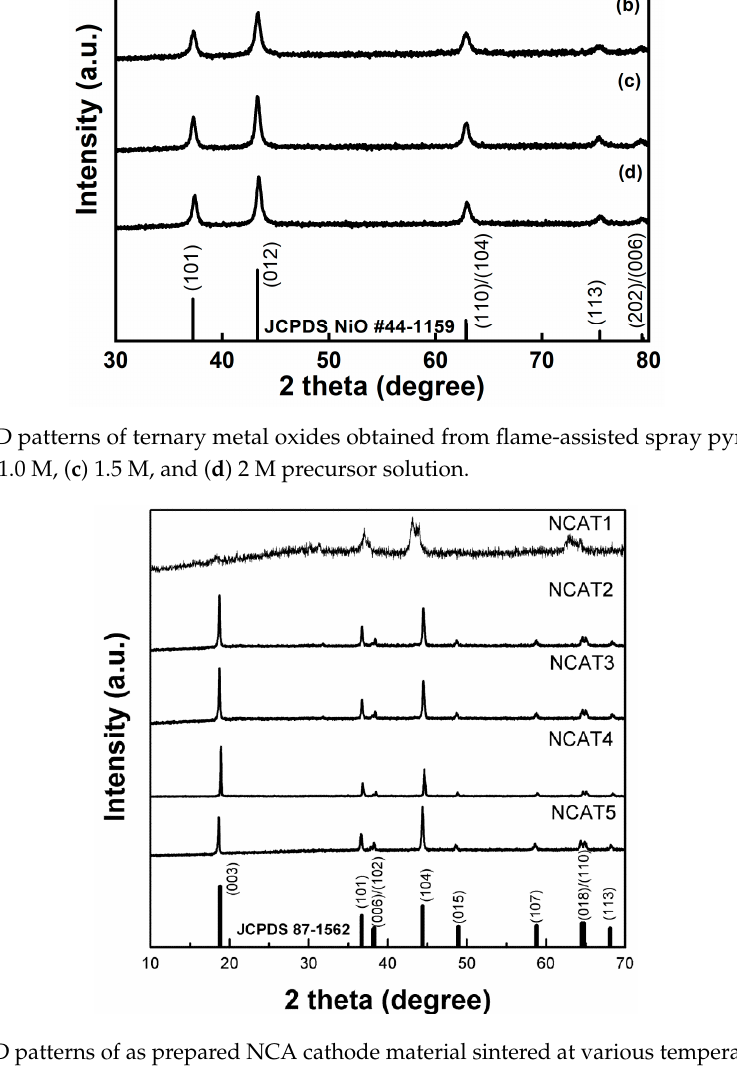
Figure 6. XRD patterns of ternary metal oxides obtained from flame-assisted spray pyrolysis using: ( a ) 0.5 M, ( b ) 1.0 M, ( c ) 1.5 M, and ( d ) 2 M precursor solution.